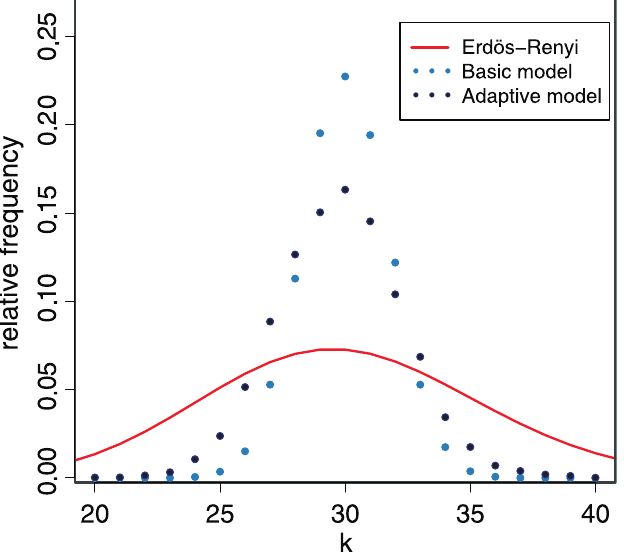
Figure 2. Emergent heterogeneity in self-organized networks. In comparison to a random graph (red), the degree distribution of networks evolved in the basic model is relatively narrow (light blue), but broadens as cost reduction for successful agents is introduced (dark (cid:80) e ) 2 , + 2( e ij + e ji − ρ ) √ , C = µ ( blue). All simulations rely on the functions B = 2 ρ √ ik k τ + ρ 2 τ +( e ij + e ji − ρ ) 2 (cid:80) B ( e + e ) . Parameters are chosen to obtain networks with identical mean R = 1 + ν ij ji k degree (basic model: ρ = 0 . 1 , τ = 0 . 124 , µ = 2 . 731 , adaptive model ρ = 0 . 395 , τ = 0 . 1 , µ = 2 . 32 , ν = 0 . 05 ). Results are averaged over 1000 networks of size N = 100